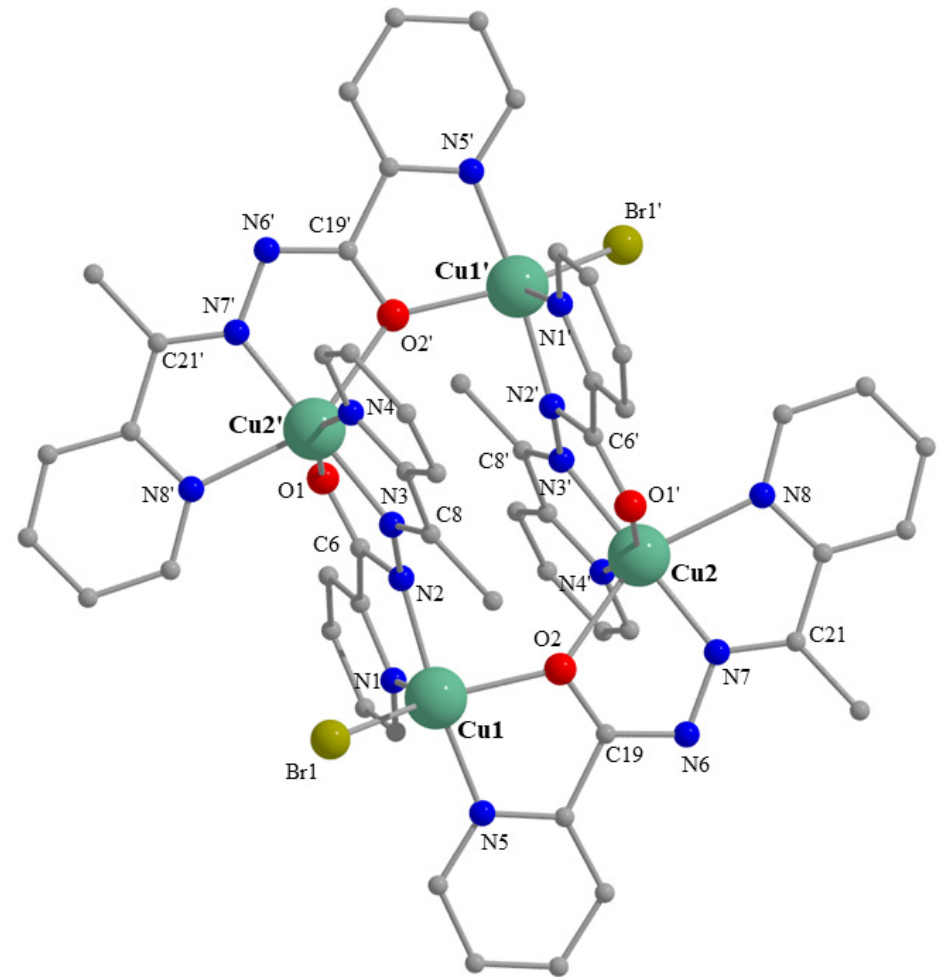
Figure 1. Partially labelled plot of the structure of the cation [Cu 4 Br 2 (L) 4 ] + 2 that is present in the crystal. Structure of 1 · 0.8H 2 O · MeOH. Symmetry code: (‘) = − x + 1, − y + 2, − z . A plot with thermal ellipsoids is presented in Figure S17.